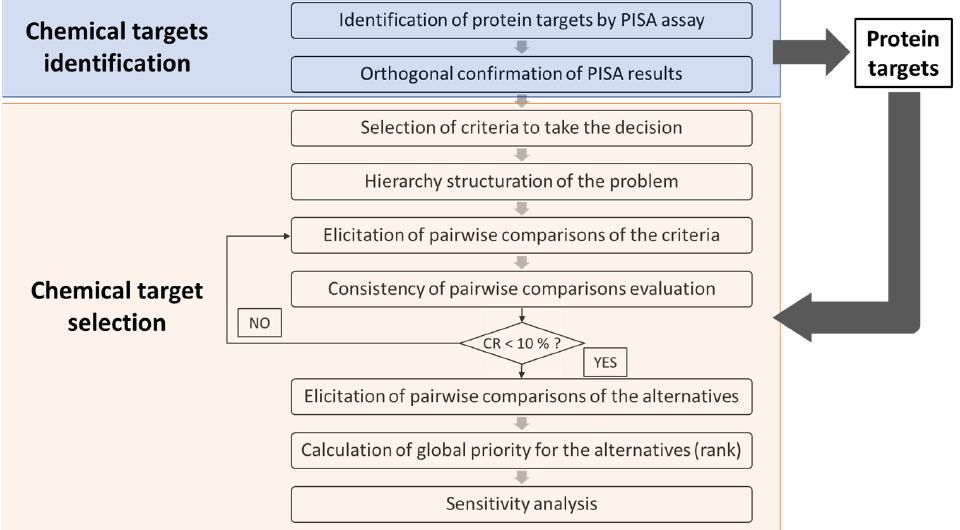
Figure 1. Workflow followed to select from identified protein targets by 2D PISA assay the priori- tized one for further studies and for its integration into AOPs. A workflow of the 2D PISA is avail- able in the supplementary information (Figure S1). CR: consistency ratio. Adapted from Yadav and collaborators